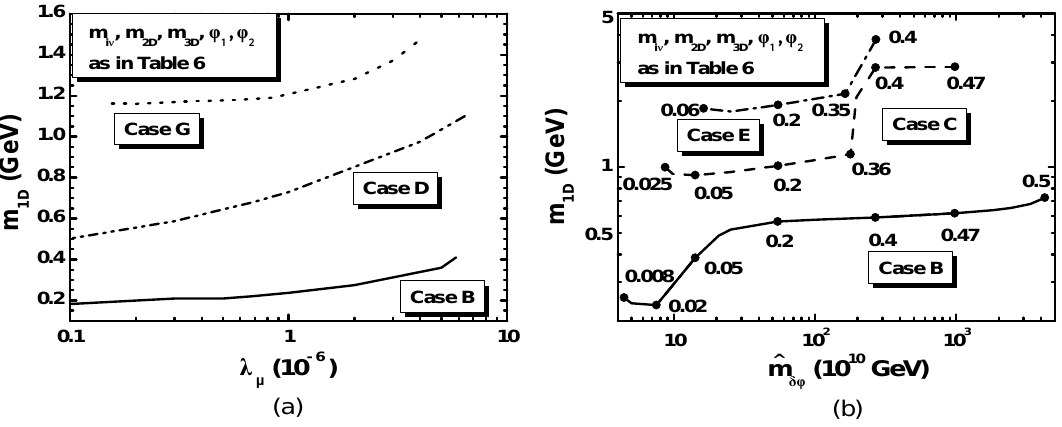
F IGURE 4 : Contours,yieldingthecentral Y B inEq.(5.12)consistentlywiththeinflationaryrequirements,inthe Figure 4. Contours, yielding the central Y B in Equation (51) consistently with the inflationary m 1D planefor ( n, r ) = (0 . 042 , 0 . 025) ; (b) m δϕ m 1D planefor n = 0 and r valuesindicatedon (a) λ µ ) = ( 0.042,0.025 ) ; ( b ) m 1D plane for ( n , r m δφ m 1D plane for n = 0 requirements, in ( a ) λ µ − − ± ± − − ± thecurves. Wealsotake K = K 2 or K 3 with N X = 2 , y = 0 . 5 andthevaluesof m iν , m 2D , m 3D , φ 1 ,and φ 2 and r values indicated on the curves. We also take K = K 2 or K 3 with N X = 2, y = 0.5 and the values ± whichcorrespondtothecasesB(solidline),C(dashedline),D(doubledot-dashedline),E(dot-dashedline), b (cid:98) of m i ν , m 2D , m 3D , ϕ 1 and ϕ 2 which correspond to the cases B (solid line), C (dashed line), D (double andG(dottedline)ofTable6. dot-dashed line), E (dot-dashed line), and G (dotted line) of Table